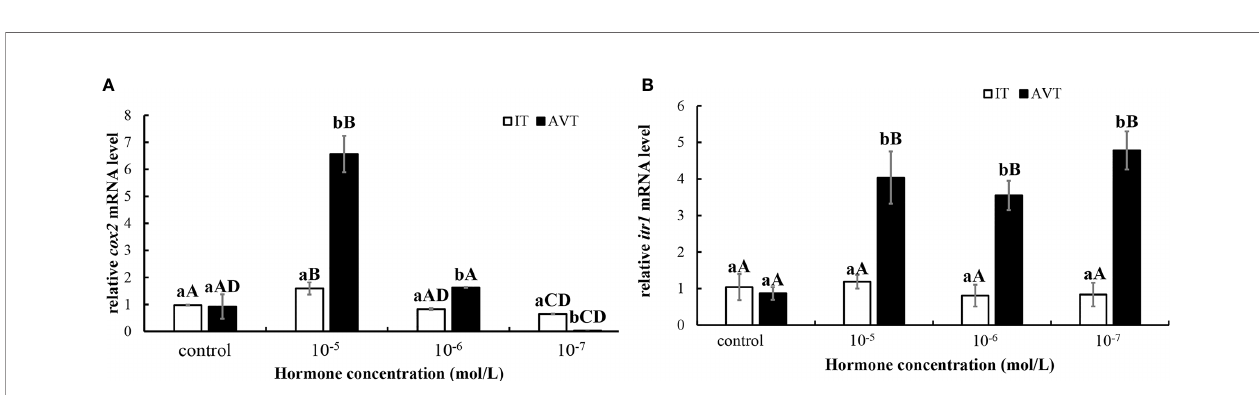
FIGURE 5 | The assay of IT (A) and AVT (B) binding to ITR1. The relative CRE luciferase activity in the presence of various concentrations of IT (10 − 6 , 10 − 7 , or 10 − 8 mol/L) and AVT (10 − 6 , 10 − 7 , or 10 − 8 mol/L) was determined by measuring fi re fl y and Renilla luciferase activities normalized to the values in the control group. Bars represent the mean values ± SEM, and different letters indicate signi fi cant differences (P < 0.05).